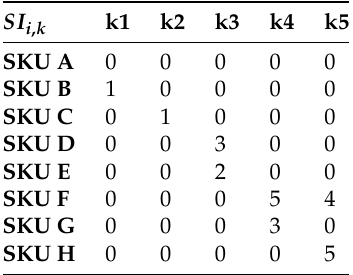
Table 2. Stroke inputs matrix, according to Figure